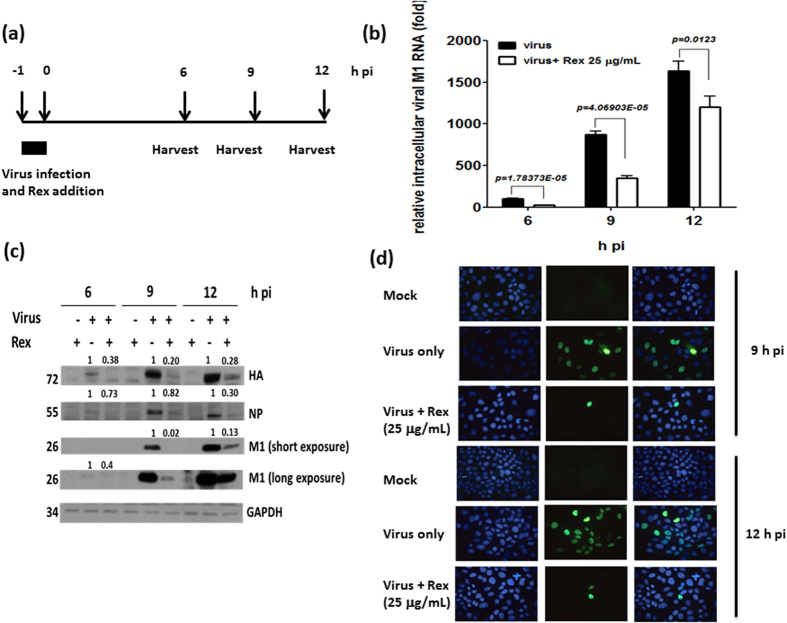
Rex affected influenza viral RNA and protein synthesis.MDCK cells were infected with influenza virus A/WSN/33 (MOI = 0.1) in the presence of Rex (25 μg/mL) at −1 to 0 h. (a) Schematic diagram of Rex treatment. The cells were collected for analysis by RT-qPCR (b), western blotting (c), and immunofluorescence microscopy (d). (b) viral RNA expression was detected by qPCR using specific primers for M1. A representative result is shown based on two reproducible experiments, where each condition was performed in triplicate. (c) The viral protein expression levels were determined by immunoblotting. Cell lysates (30 μg/lane) were subjected to SDS-PAGE and western blotting using antibodies against viral proteins (HA, NP, and M1) and an internal control (GAPDH). A representative result is shown based on three experiments. (d) Indirect immunofluorescence was evaluated using specific NP antibodies. Cellular nuclei were stained with Hoechst dye. A representative result is shown based on three experiments.